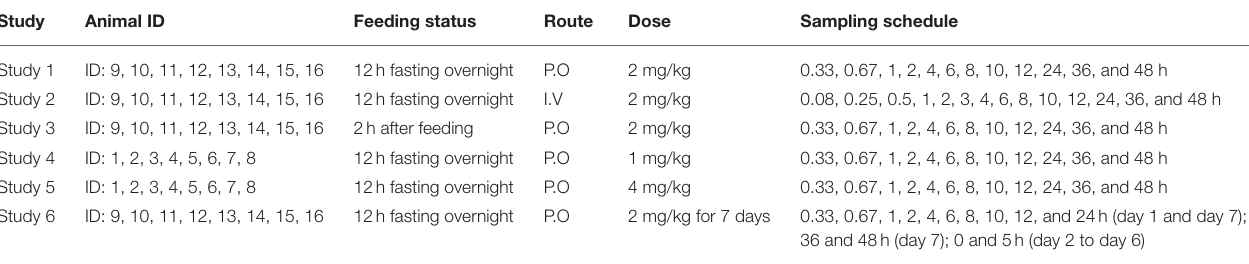
TABLE 1 | List of vitacoxib dosing and sampling schedules in cats included for NLME data analysis. Study Animal ID Feeding status Route Dose Sampling